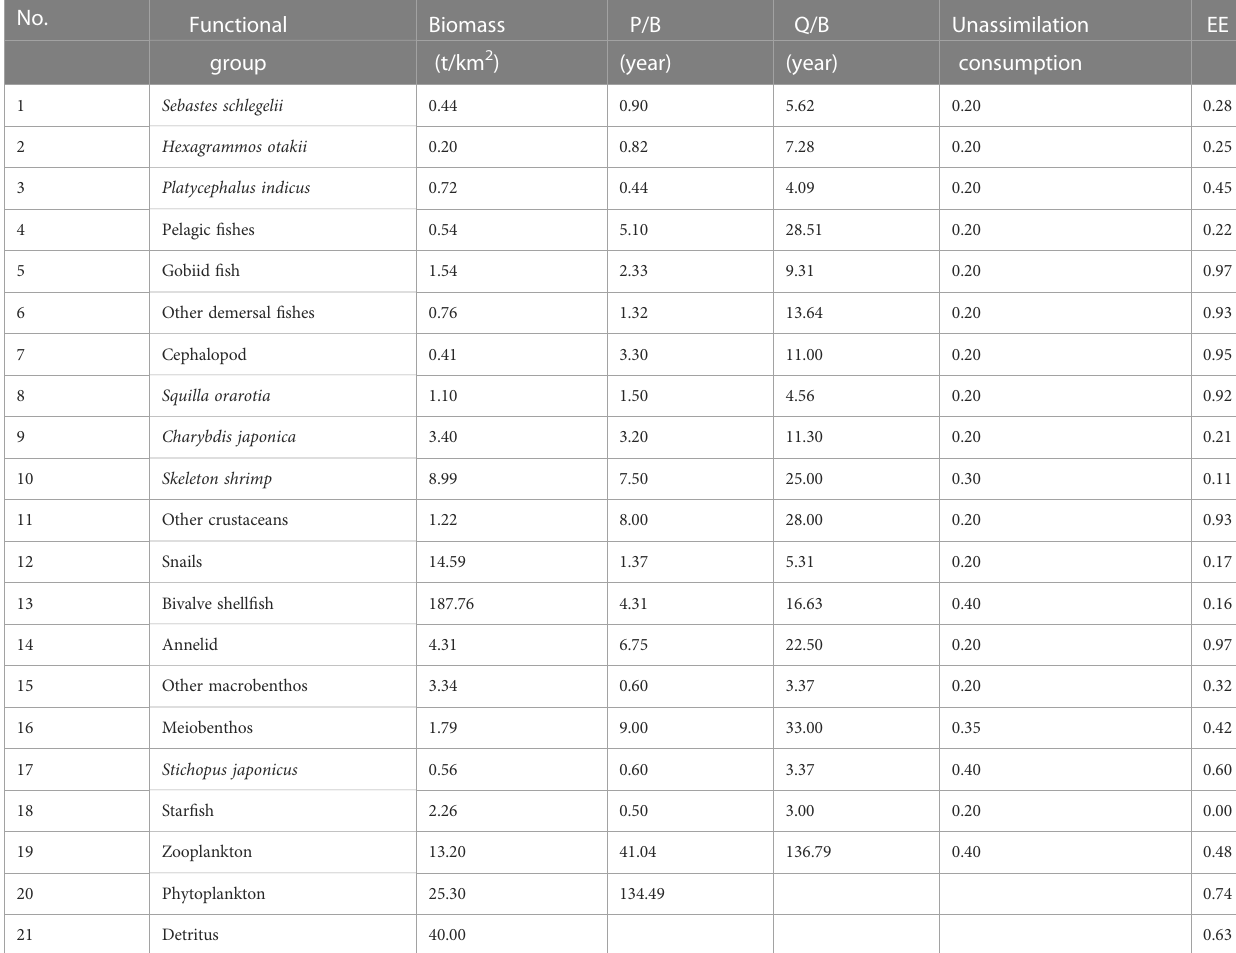
TABLE 2 B, P/B, Q/B, EE, and TL of the study marine ranching ecosystem in Bohai Bay,